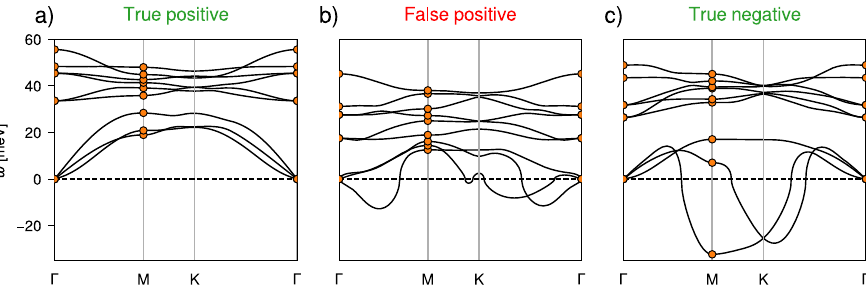
Fig. 2 Possible outcomes of the CBP protocol. Phonon band structure for monolayer MoS 2 in the H-phase ( a ), NbSSe ( b ), and MoS 2 in the T-phase ( c ). Note that imaginary phonon frequencies are represented by negative values. The CBP protocol (orange dots) is suf fi cient to conclude that a material is dynamically stable (unstable) in the situations depicted in a and c . In contrast, when the relevant distortion requires a supercell larger than 2 × 2, and the phonon frequencies are real at the center and boundary of the BZ, the CBP protocol will result in a false- positive